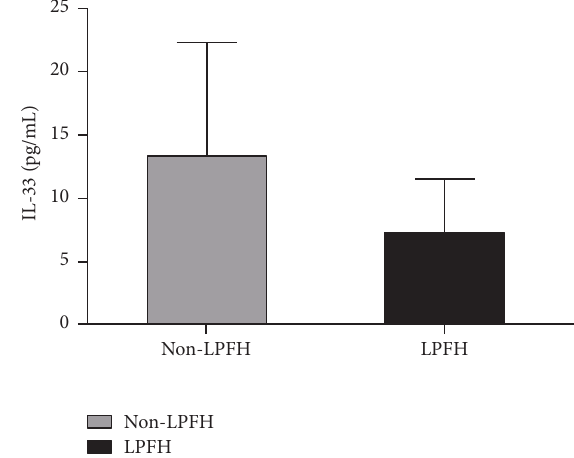
Figure4:TheIL-33levelsweresignificantlyhigherinthenon-LPFH group than that in the LPFH group ( 𝑃 = 0.034